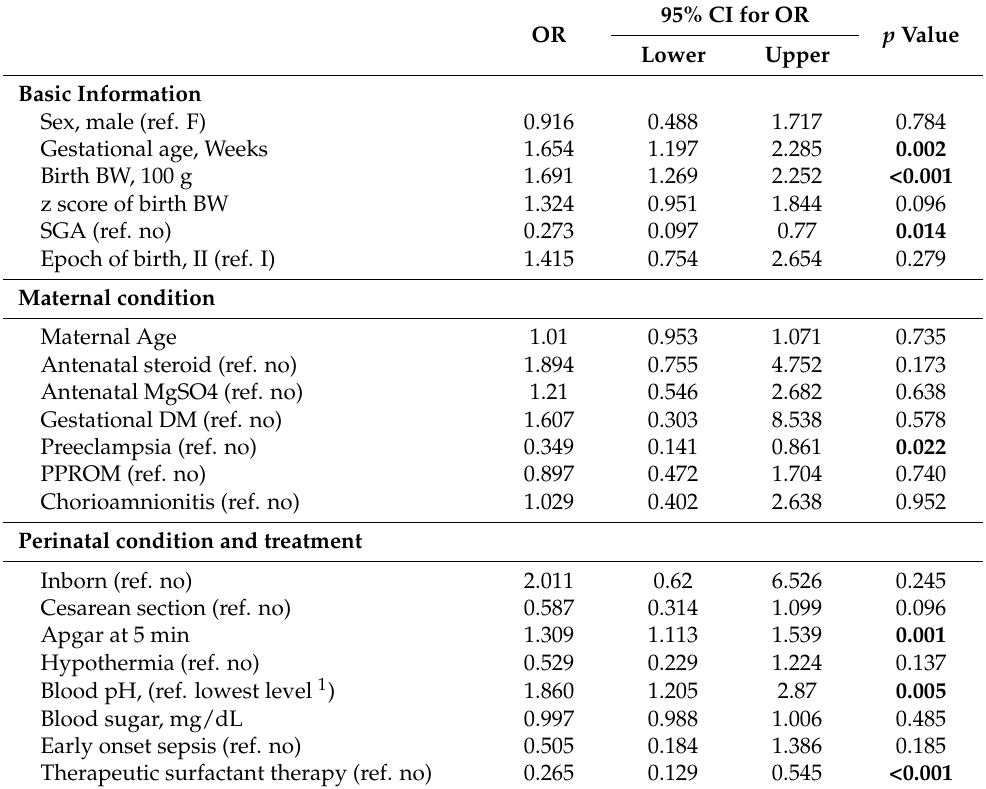
95% CI for OR p Value OR Lower Upper